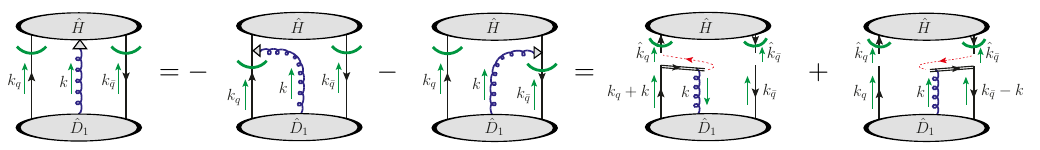
Figure 7. Graphic representation of the two steps to detach a longitudinally polarized collinear gluon from the ˆ D 1 to the ˆ H , and reconnect it to corresponding gauge links of the ˆ D 1 . The triangles at the end of gluon lines mean the use of Ward identity, and the red thin dashed lines represent the color